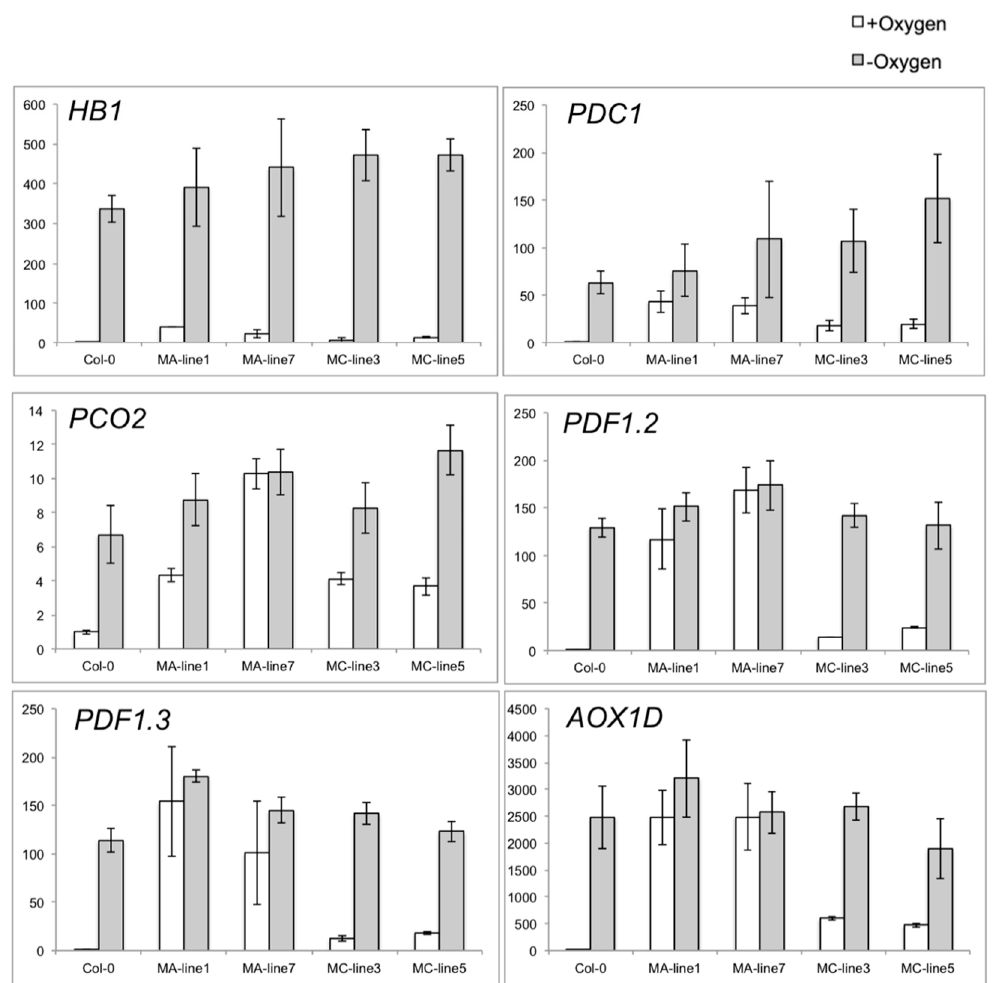
Figure 7. Quantitative real-time PCR validation of transcriptome data for selected genes. Relative expression was normalized to the abundance of UBQ10 . Data represent mean ± SE ( n = 3).